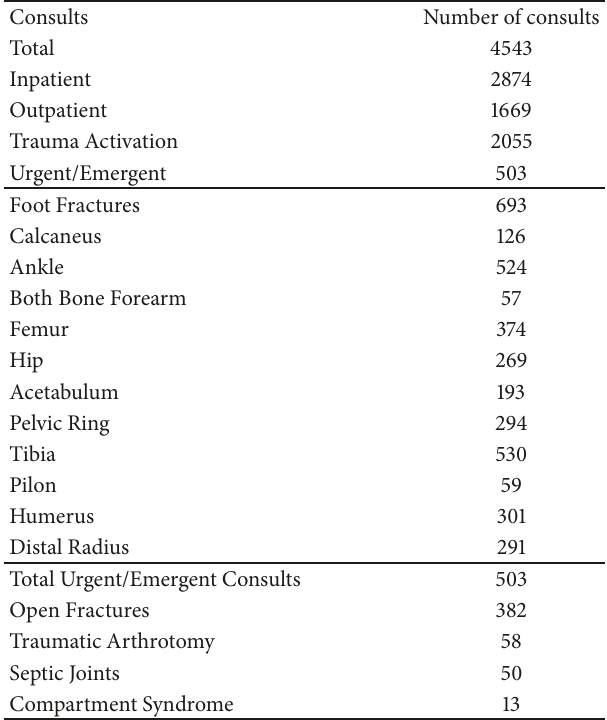
Table 1: Number and type of consults over study period.